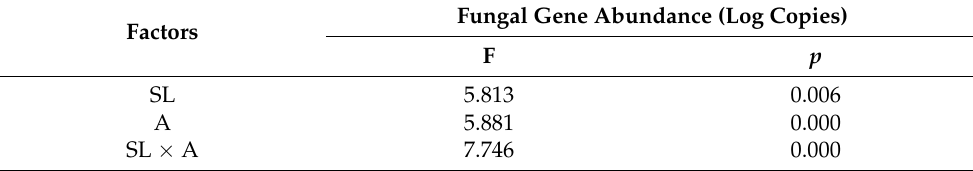
Figure 2. The quantitative gene abundance per gram dry soil in different soil layers and altitudes. Different lower-case superscript letters on different bars indicate significant differences between samples (Duncan’s test, p < 0.05). Table 1. The effect of elevations and soil layers on fungal gene abundance as indicated by two-way